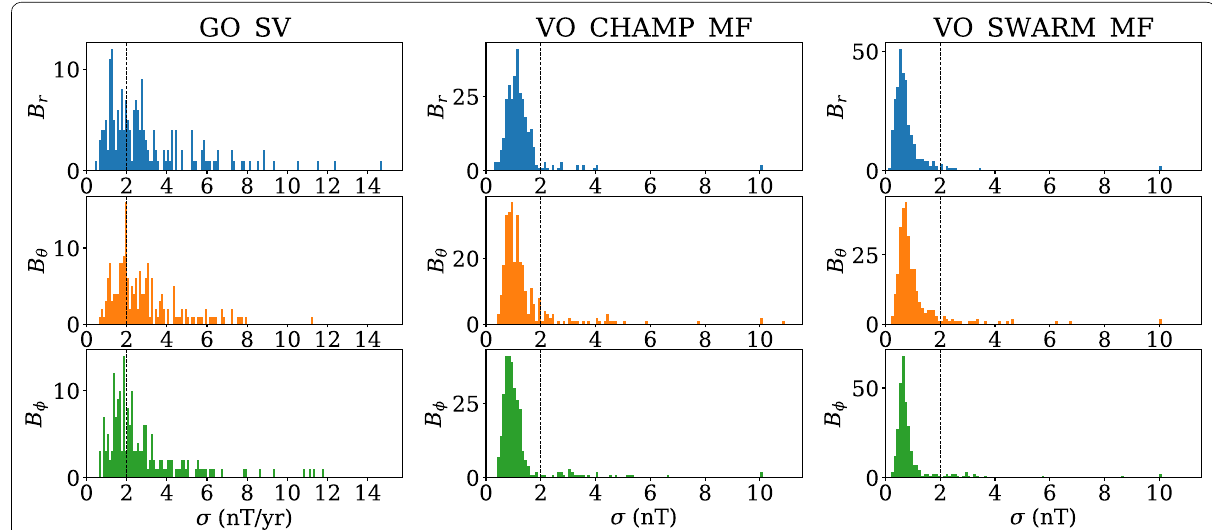
Fig. 1 Histogram of observation errors σ obs GO and σ obs VO for GO and VO datasets, separated by spatial components. The dashed line represents the value of modeling error σ mod VO (see text for details). The observation errors for F were derived from these observation errors (see